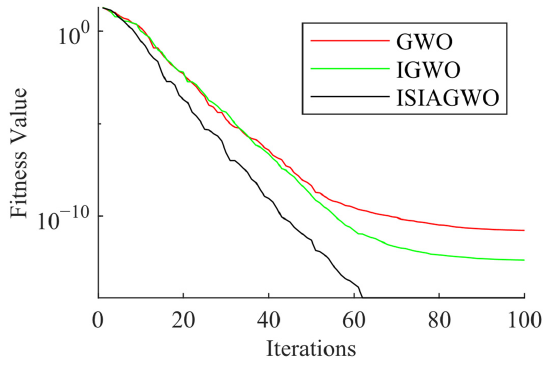
Figure 6. Ackley’s function optimization curve.